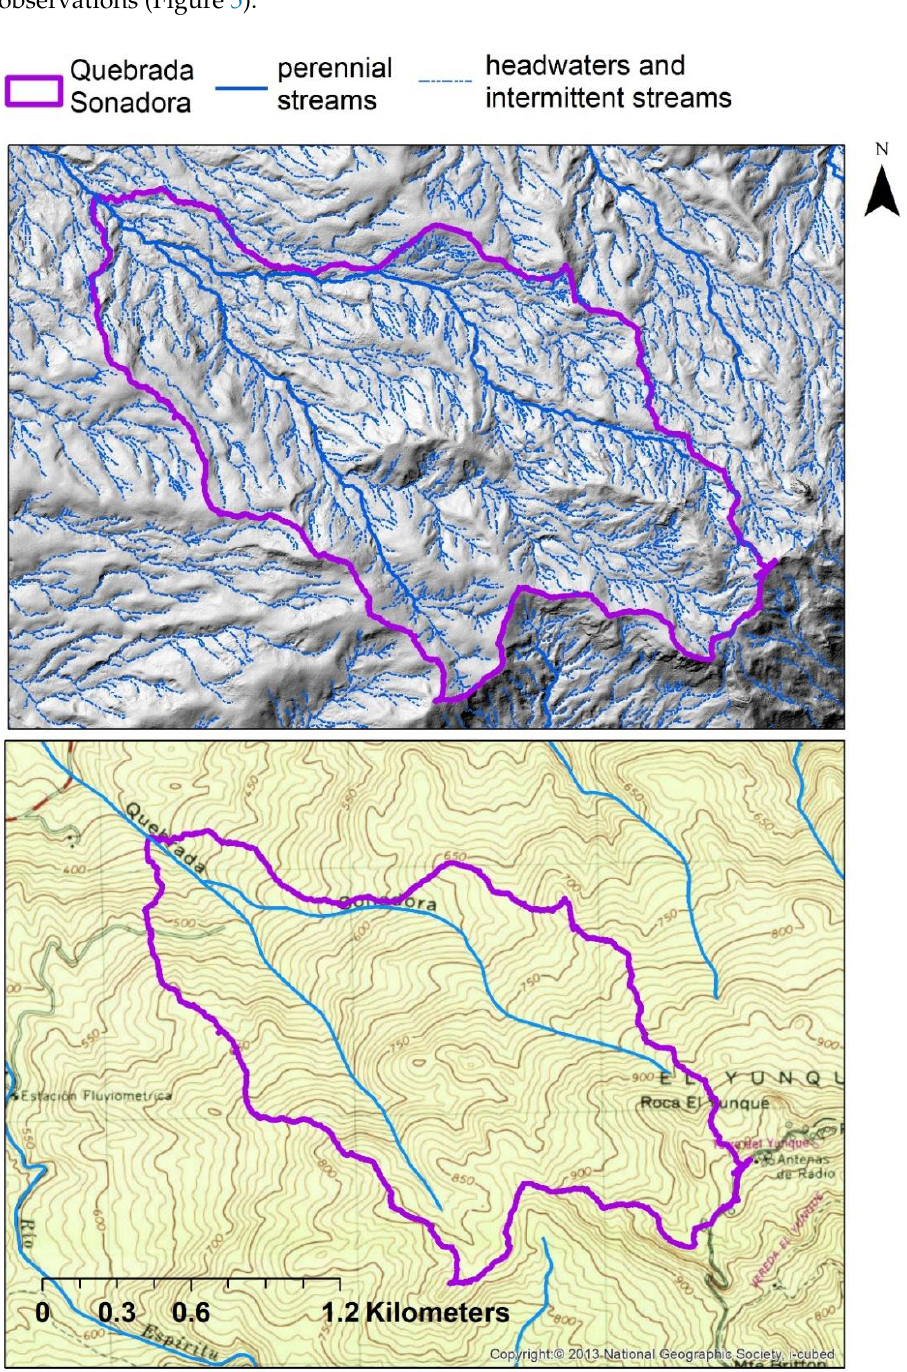
Figure 4. Bottom panel: Delineation of the Quebrada Sonadora sub-watershed boundary (purple color outline) with the two permanent bodies of water shown on USGS quadrangle topographic maps. Top panel: densification, with flow accumulation ≥ 2000 cells. This densification registers 1216 elements within the Sonadora watershed. Most headwaters and tributaries shown are perennial. Long-term monitoring shows that headwaters in the easternmost portion of the Sonadora headwaters, for example, are perennial up to 50–100 m from the ridge.